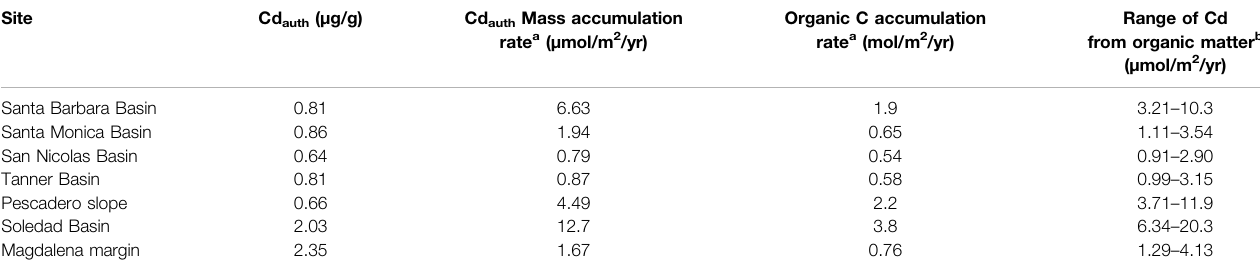
a Calculated by multiplying mass accumulation rate shown in Table 1 by Cd or Organic C concentration ( Table 2 ). b Calculated by multiplying organic C accumulation rate by molar Cd:C ratio of 1.69 × 10 − 6 (min) and 5.4 × 10 − 6 (max) from Ho et al. (2003) and Bourne et al.